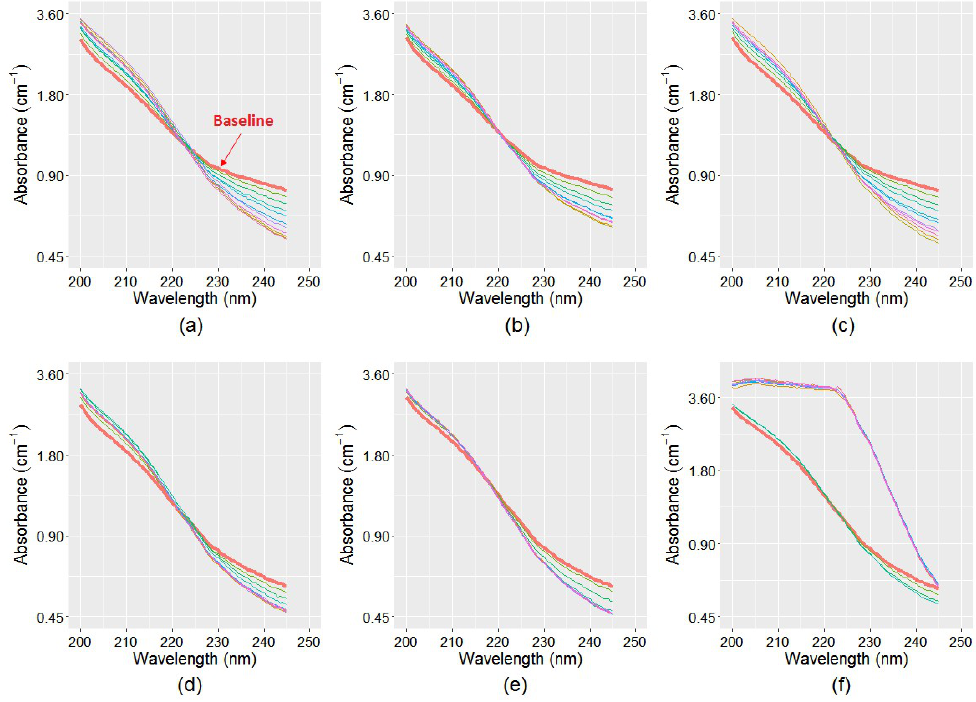
Figure 5. Recorded spectra of the six samples for a period of eight weeks: ( a ) TB-WTP unprocessed sample; ( b ) TB-WTP 0.22 µ m filtered sample; ( c ) TB-WTP enhanced sample; ( d ) Meningie unprocessed sample; ( e ) Meningie 0.22 µ m filtered sample; and ( f ) Meningie enhanced sample. Nitrification was observed in Sample6 (Figure 5f). Due to NO x − production, the subsequent spectra in all